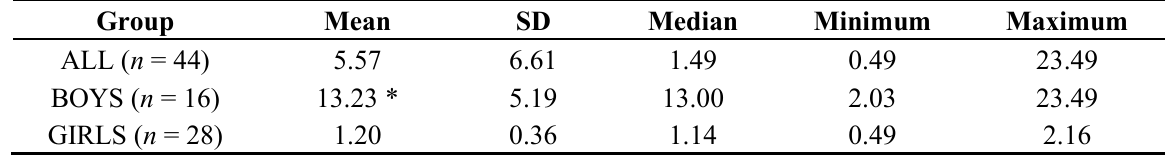
Table 2. Testosterone levels (in nmol/L) in blood of children living in the area of Flix. Group Mean SD Median Minimum Maximum ALL ( n = 44) 5.57 6.61 1.49 0.49 23.49 BOYS ( n = 16) 13.23 * 5.19 13.00 2.03 23.49 GIRLS ( n = 28) 1.20 0.36 1.14 0.49 2.16 SD: standard deviation. * Significant differences between boys and girls at p <